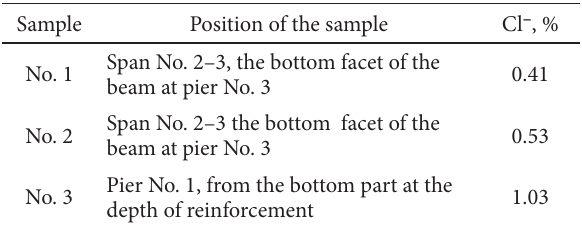
table 1. The chloride content of the bridge over the railroad (“Gaisa tilts”) Sample